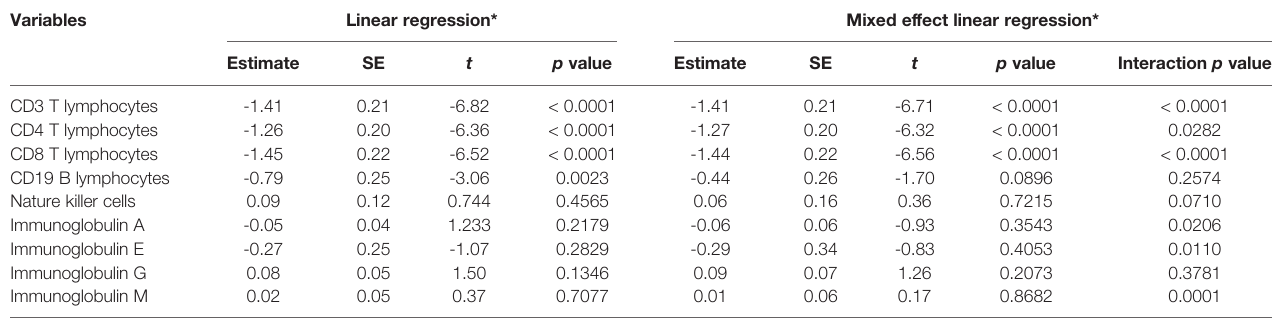
TABLE 4 | Mixed effect linear model of immunological indicators adjusted by variables with signi fi cant differences in constituent ratio shown in Table 1 . Variables